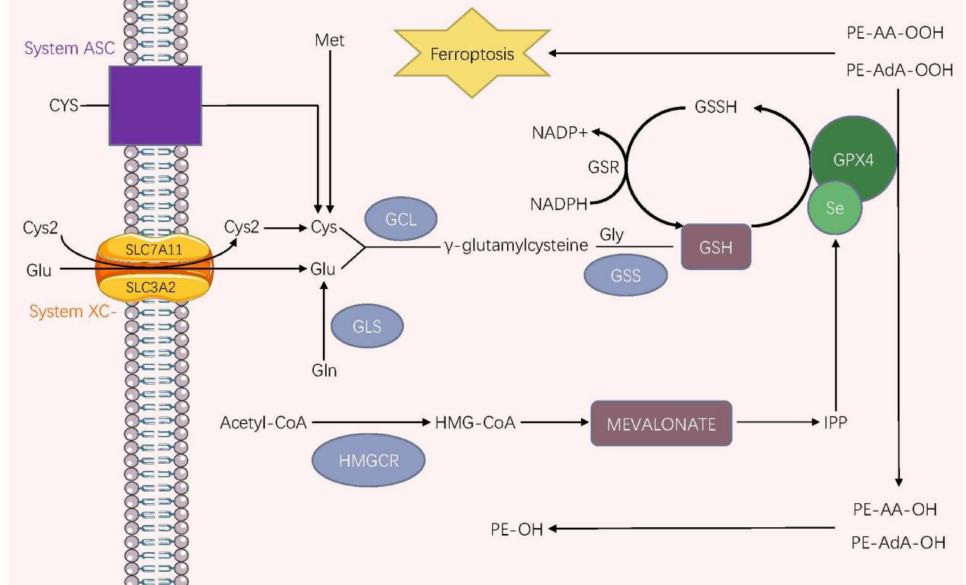
Figure 1. The ferroptosis regulatory pathway correlated to GPX4. Under oxidative conditions, the most upstream event of ferroptosis is the importation of Cys2 via system XC-. Cys2 is then reduced to Cys, which the system ASC can directly take under reduced conditions after it has been imported. In addition, there is another source of intracellular Cys in which Met is converted into Cys through the transsulfuration pathway. GSH, a vital antioxidant, is created by Cys, Glu, and Gly under two catalysis steps involving GCL and GSS cytosolic enzymes. GPX4 accepts electrons from GSH molecules, which reduces the toxic PE-AA-OOH/PE-AdA-OOH into nontoxic PE-AA- OH/PE-AdA-OH, ultimately inhibiting ferroptosis. GSH, the electron donor, is oxidized to GSSG that is then reduced to GSH by NADPH under the reductase GSR. Abbreviations: Gln, glutamine; GLS, glutaminase; Se, selenium; HMGCR, 3-hydroxy-3-methylglutaryl-CoA reductase;